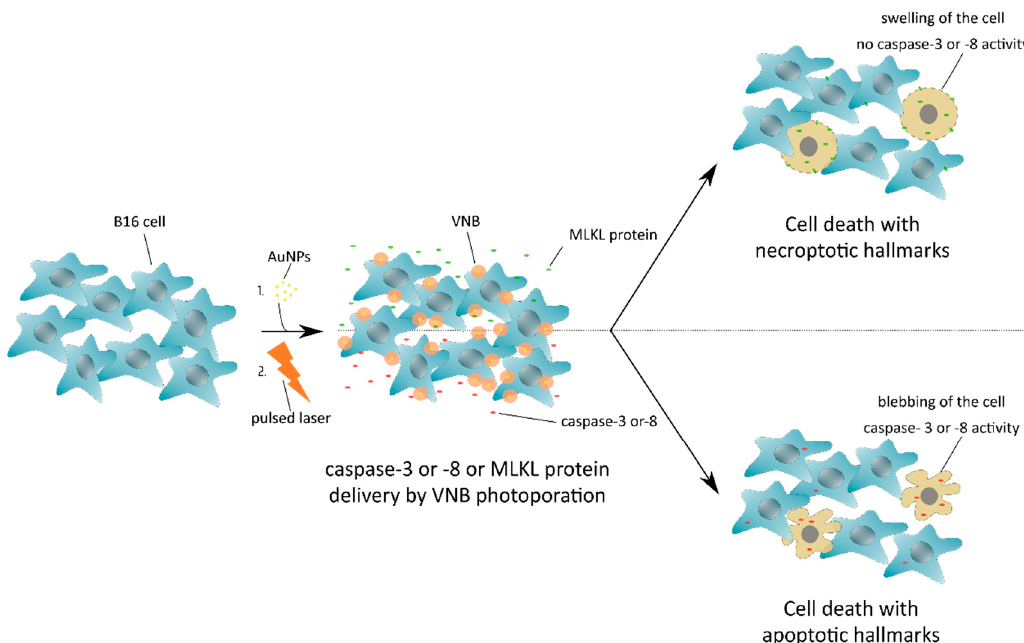
Figure 1. Induction of cell death with necroptotic or apoptotic hallmarks after mixed-lineage kinase domain-like (MLKL) protein or caspase-3/-8 delivery by vapor nanobubble (VNB) photoporation, respectively. B16 cells are first incubated with gold nanoparticles (AuNPs) that adsorb onto the plasma membrane, followed by a nanosecond pulsed laser treatment that results in the formation of vapor nanobubbles (VNBs). Collapse of the expanding VNBs leads to membrane pore formation and allows the extracellular MLKL or caspase -3/-8 protein to diffuse into the cell cytoplasm. After a short period of incubation, the MLKL protein has evoked cell death with necroptotic hallmarks, whereas transduced caspase-3/-8 protein results in apoptosis.